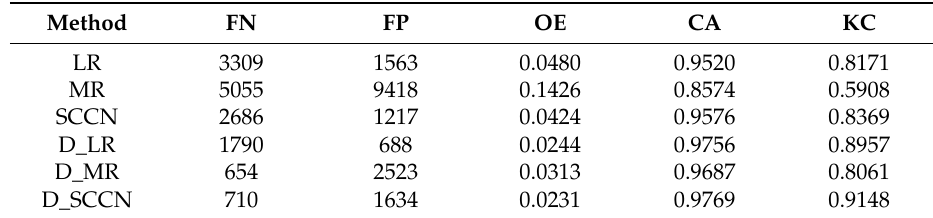
Figure 14. Difference maps and resulting maps of the Ottawa dataset obtained by different methods. ( a ) Difference map by LR. ( b ) Difference map by MR. ( c ) Difference map by SCCN. ( d ) Resulting map by LR. ( e ) Resulting map by MR. ( f ) Resulting map by SCCN. ( g ) Resulting map by DCAPS based on LR (D_LR). ( h ) Resulting map by DCAPS based on MR (D_MR). ( i ) Resulting map by DCAPS based on SCCN (D_SCCN) ( j ) Reference map. Table 2. Values of the evaluation criteria on the Ottawa dataset by different methods and these methods based on the deep capsule